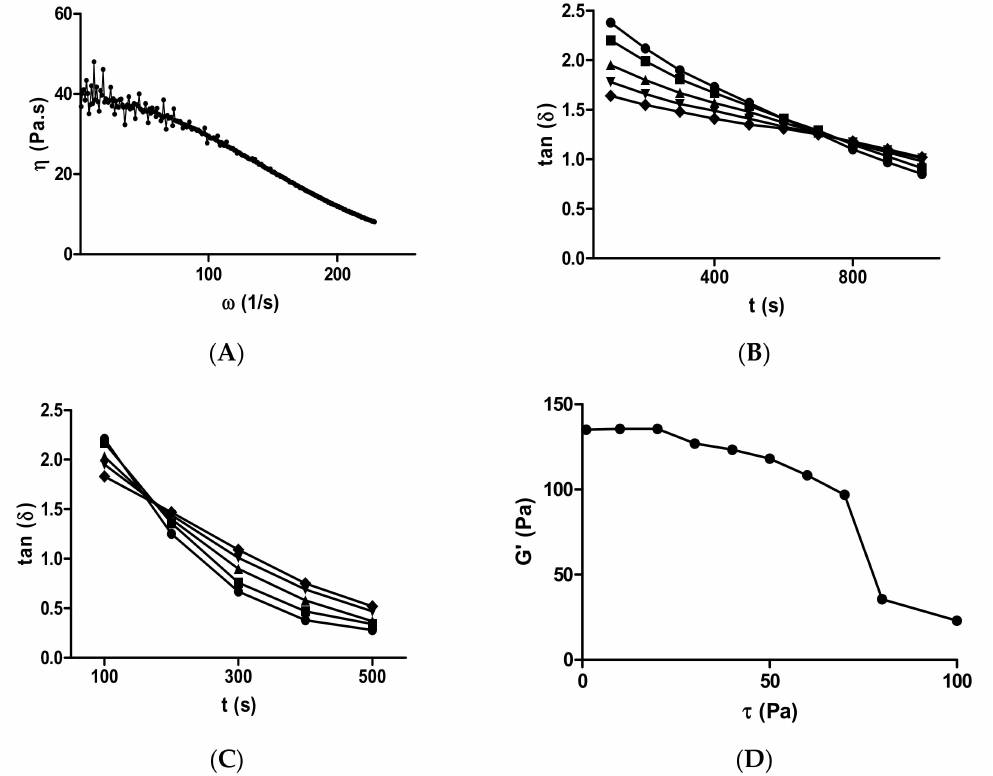
Figure 1. Rheological characterization of silanized-hydroxypropylmethylcellulose (Si-HPMC) solution and gel. ( A ) Flow curves (viscosity vs. shear rate) of a 4% Si-HPMC solution (pH 7.0). ( B ) Tan ( δ ) vs. time (in order to determine t gel ) of a 2% Si-HPMC hydrogel (pH 7.0) at 23 ◦ C and ( C ) at 37 ◦ C. Tan ( δ ) was determined at five oscillation frequencies: 0.30 Hz ( ), 0.50 Hz ( (cid:4) ), 1 Hz ( (cid:78) ), 1.80 Hz ( (cid:72) ), and 3.2 Hz ( (cid:7) ). ( D ) The equilibrium storage modulus ( G (cid:48) ) was determined for applied stress amplitudes ( τ ) ranging from 0.1 to 1000 Pa and a fixed frequency of 1 Hz after 24 h for a 2% Si-HPMC hydrogel (pH 7.0) at 37 ◦ C. Each rheological test was repeated three